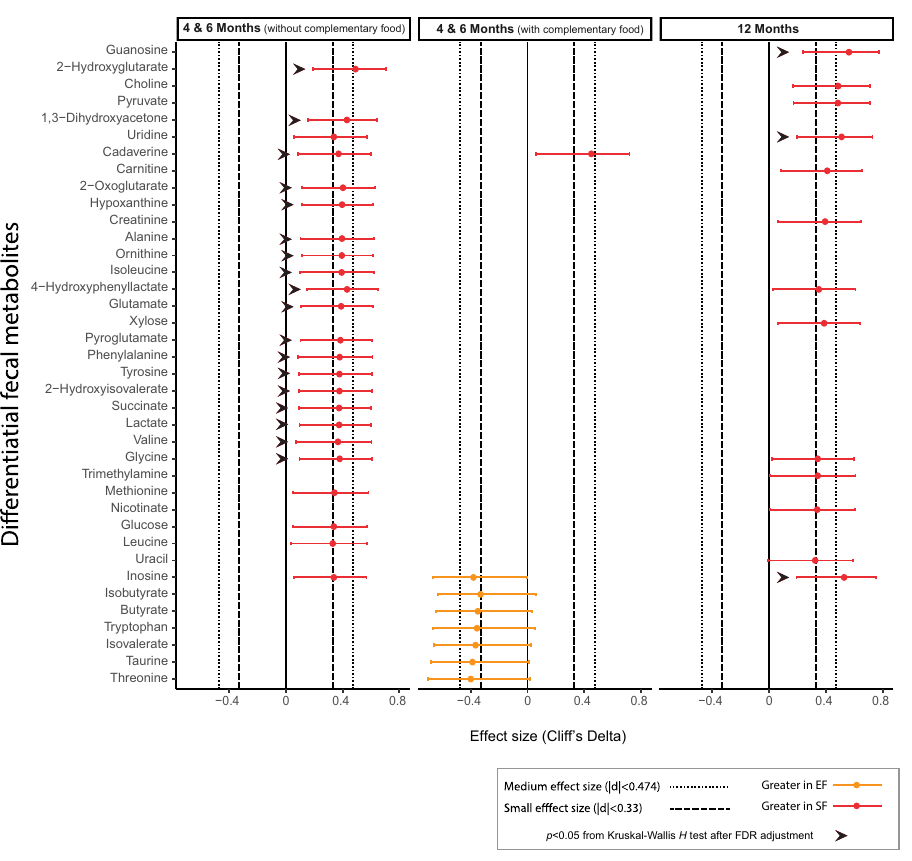
Figure 5. Fecal metabolites that are significantly different between formula-fed infants who consumed standard formula (SF, red) and experimental formula (EF,